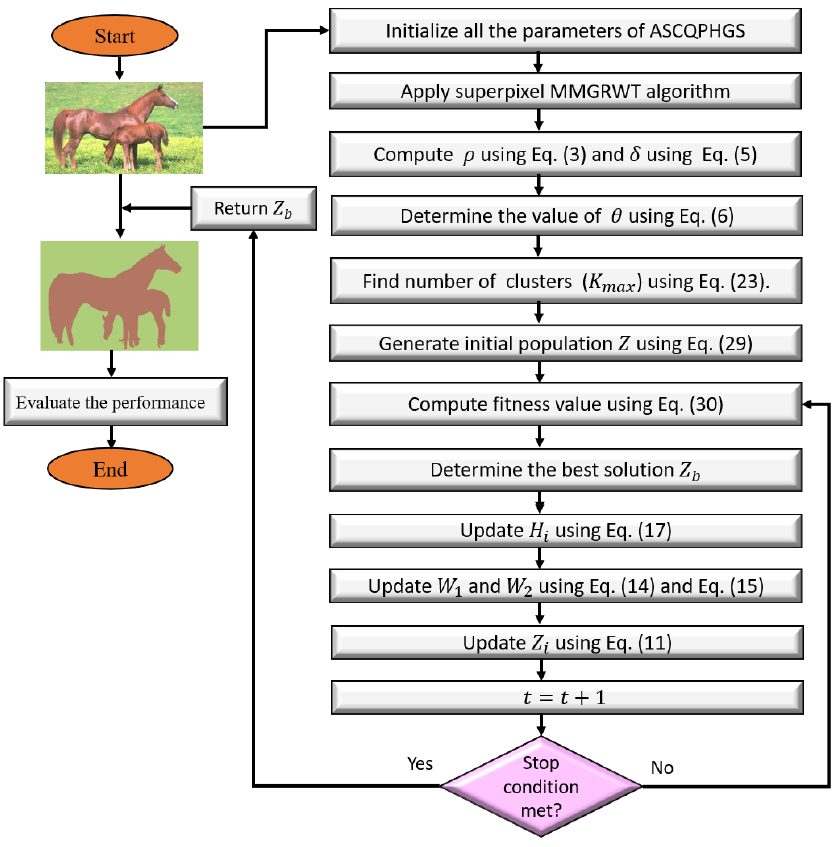
Figure 1. The steps of developed ASCQPHGS for color image segmentation.